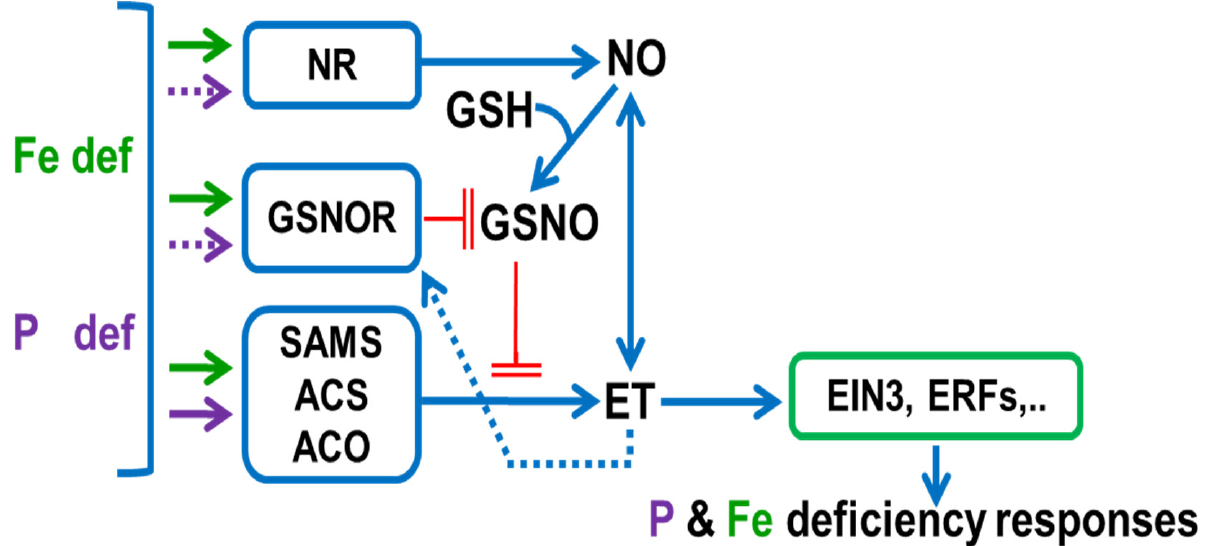
Figure 2. Model to summarize the relationship between ethylene, NO and GSNO in Fe- and P-deficient roots. Fe and P deficiency conditions induce several enzymes related to NO and ET synthesis, like NR, SAMS, ACS and ACO. Each one (NO, ET) mutually influences the synthesis of each other. Fe and P deficiency can also induce the GSNOR enzyme, which leads to a decrease in GSNO levels. GSNO, formed from NO and GSH, can limit ET synthesis through SAMS nitrosylation. On the other hand, ET can promote GSNO degradation by inducing NR and the GSNOR enzyme. Finally, ET, through EIN3 and other ERF TFs, would activate Fe and P deficiency responses. ET, ethylene; GSH, glutathione; GSNO, S -nitrosoglutathione; NO, nitric oxide. NR, nitrate reductase; GSNOR, GSNO reductase; SAMS, S-Adenosylmethionine synthetase; ACS, ACC syntase; ACO, ACC oxidase. → : promotion (dashed line indicates promotion based on preliminary results); ─╢ : inhibition. Based on [112,138,142–144].